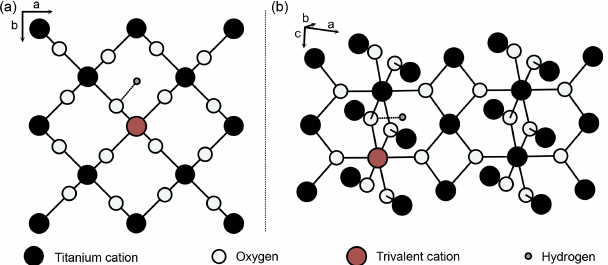
Figure 2. Structure of rutile (after van Hippel et al., 1962; Swope et al., 1995). (a) View perpendicular to crystallographic c axis, (b) per- spective view. Schematic depiction of linked substitution of trivalent cations for Ti 4 + onto octahedral sites and incorporation of H + in a slightly distorted interstitial (1 / 2 0 0) position, with an OH-band distance of 1.05Å (Swope et al.,